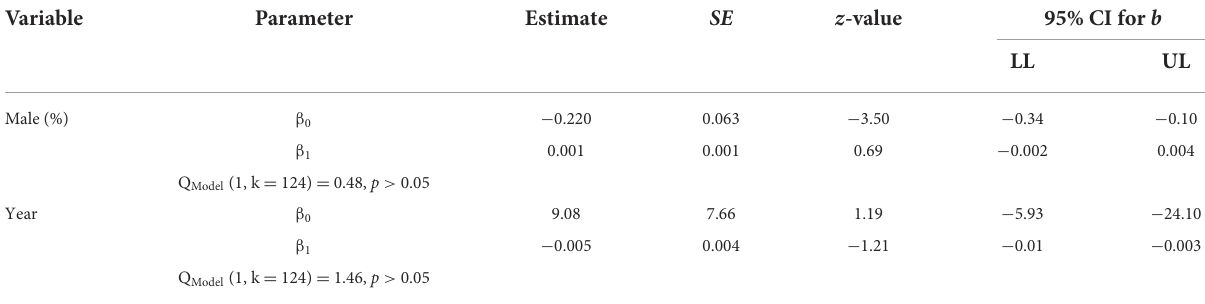
TABLE 4 Meta-regression analyses of gender and year. Variable